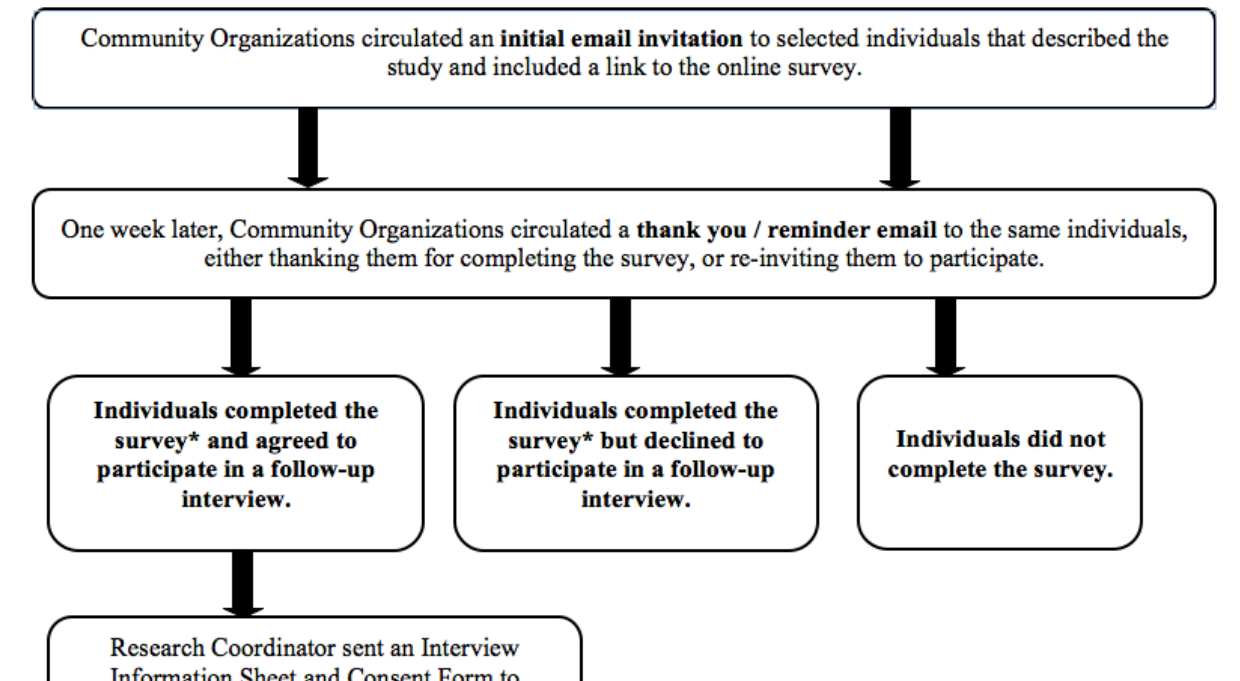
Figure 1. Overview of pilot survey